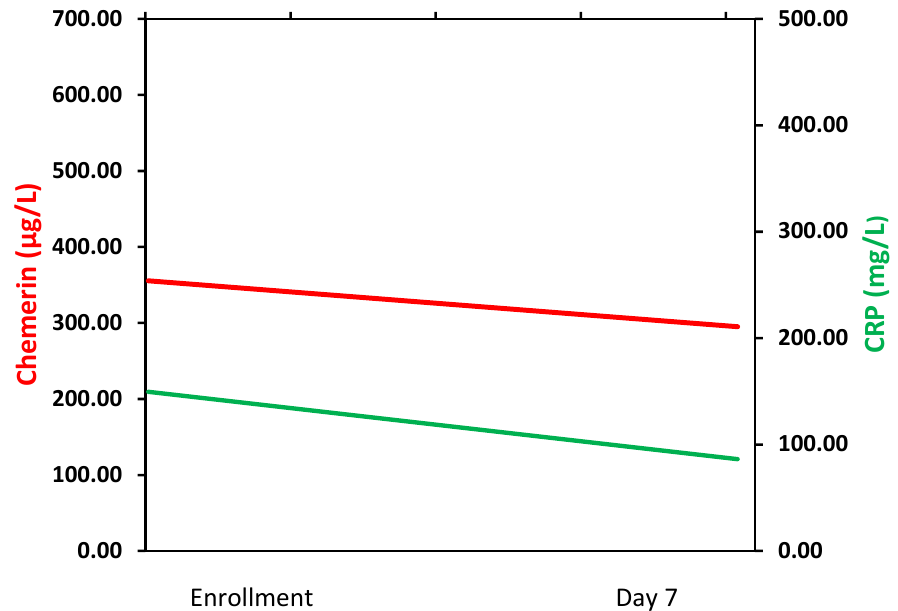
Figure 3. Graphical trend of changes over time of circulating chemerin and C-reactive protein (CRP) (from enrollment to day 7).